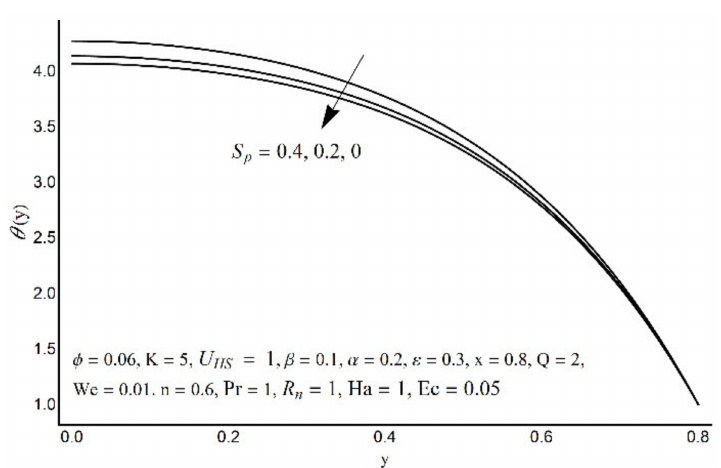
Figure 13. The temperature field for various values of S p